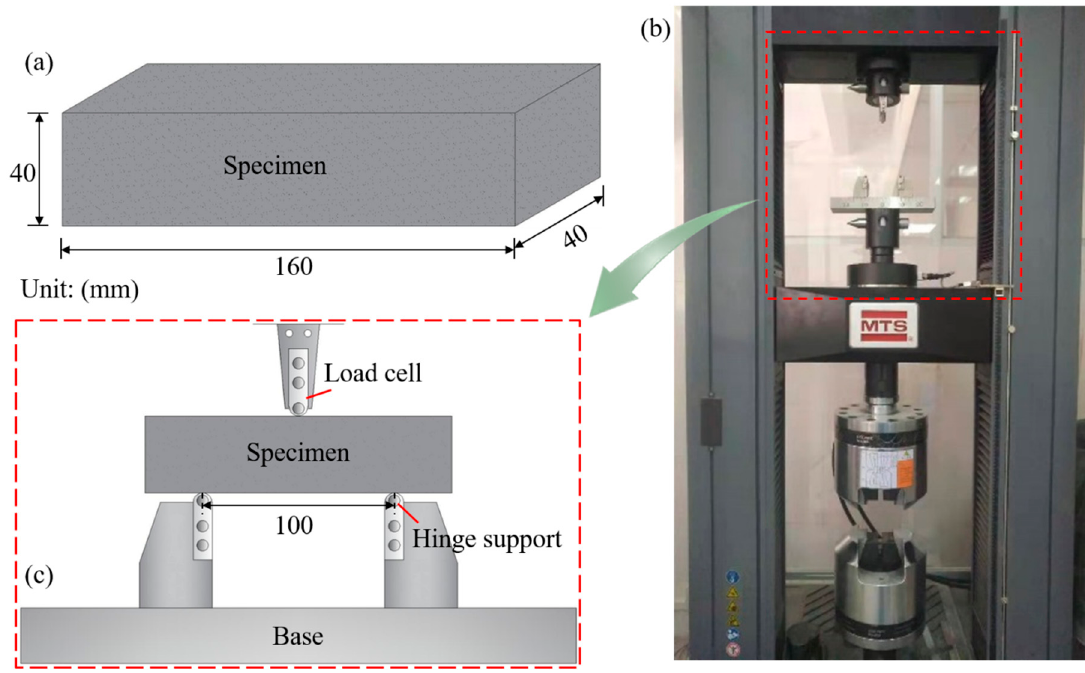
Figure 1. Specimen and test setup: ( a ) specimen; ( b ) testing machine; ( c ) test setup.